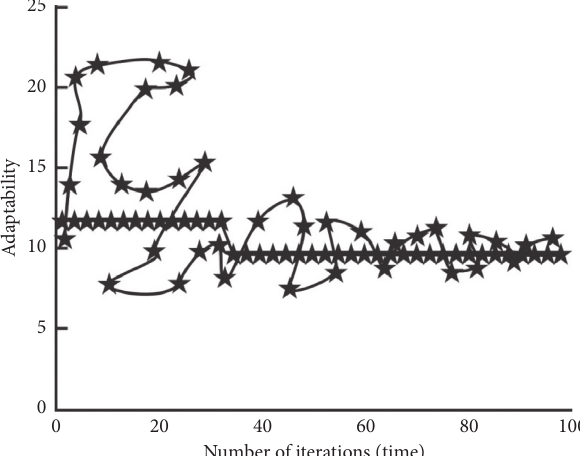
Figure 5: The optimal path length and average path length of each generation.